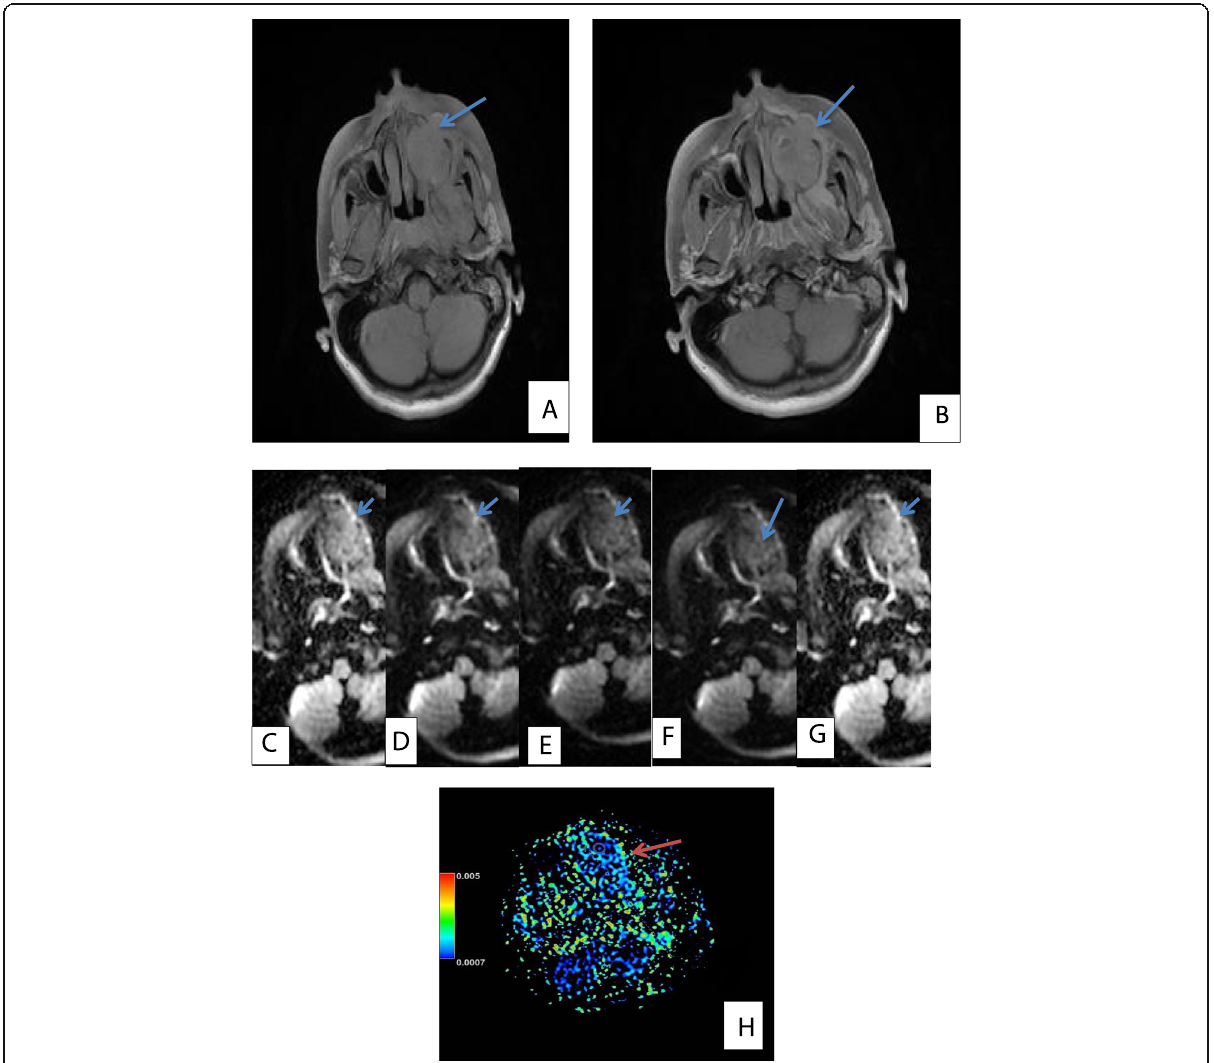
Fig. 2 Thirty- five-year-old female patient with adenoid cystic carcinoma of salivary gland centered upon the left maxillary sinus. a Axial T1. b Axial T1 + C. c – g Axial diffusion-weighted imaging with b values: 50, 400, 800, and 1000 respectively, h ) ADC map, it displayed low signal intensity in T1, with homogeneous enhancement after IV contrast, while the cystic parts show no enhancement. The lesion elicited high signal intensity in DWI, in both low and high b values (cystic areas are excluded) with corresponding low signal intensity in ADC map (restricted diffusion), ADC value = 0.77 × 10 − 3 s/mm 2